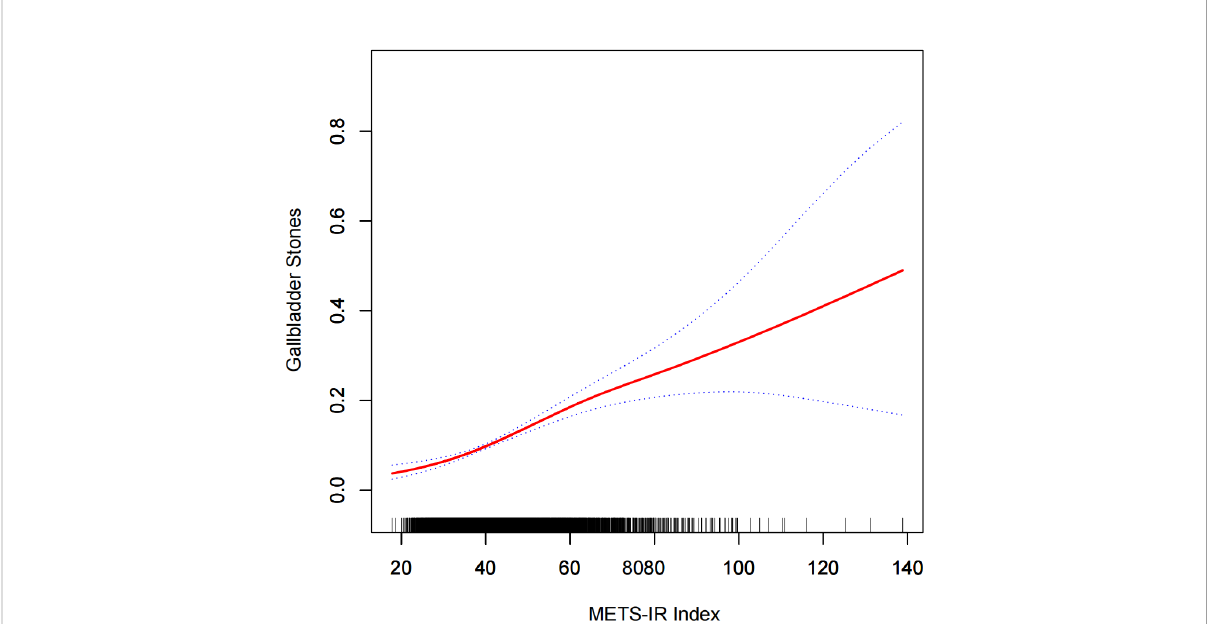
FIGURE 2 Densitometric dose-response relationship between METS-IR index and gallbladder stone prevalence. The area between the upper and lower dashed lines is indicated as the 95% CI. the red line is connected by the magnitude of the METS-IR index into a continuous line. Adjustments were made for all covariates except for effect modi fi ers.